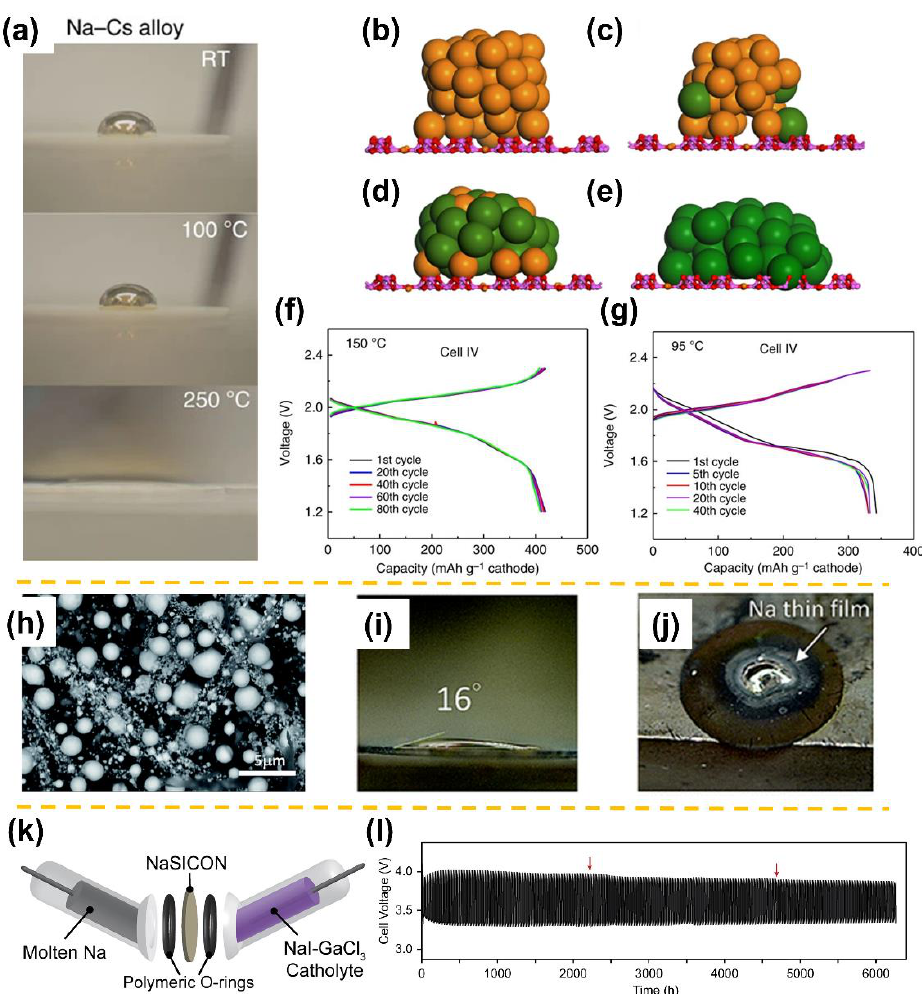
Figure 1. ( a ) Liquid Na-Cs alloy (molar ratio of 1:4) drops on untreated BASE at different temperatures. Simulated atomic structures of liquid Na-Cs alloy droplets on BASE at 100 °C for ( b ) Na, ( c ) Na-Cs (molar ratio of 4:1), ( d ) Na-Cs (molar ratio of 1:4), and ( e ) Cs liquid. The Al, O, Na, and Cs are colored purple, red, orange, and dark green, respectively. Electrochemical performance in terms of voltage profiles of Na-Cs||BASE||S cells operated at ( f ) 150 and ( g ) 90 °C (adapted with permission from Springer Nature). ( h ) SEM image showing the surface morphology of BASE treated with lead acetate trihydrate at 400 °C. The front view ( i ) and corresponding top-view ( j ) of liquid Na sessile drops on the treated BASE measured at 200 °C (adapted with permission from Royal Society of Chemistry). ( k ) Schematic view for the assembly of a Na||NASICON||NaI-GaCl 3 battery and ( l ) its long-term cycling voltage profile at 5 mA cm −2 (adapted with permission from Cell Press).